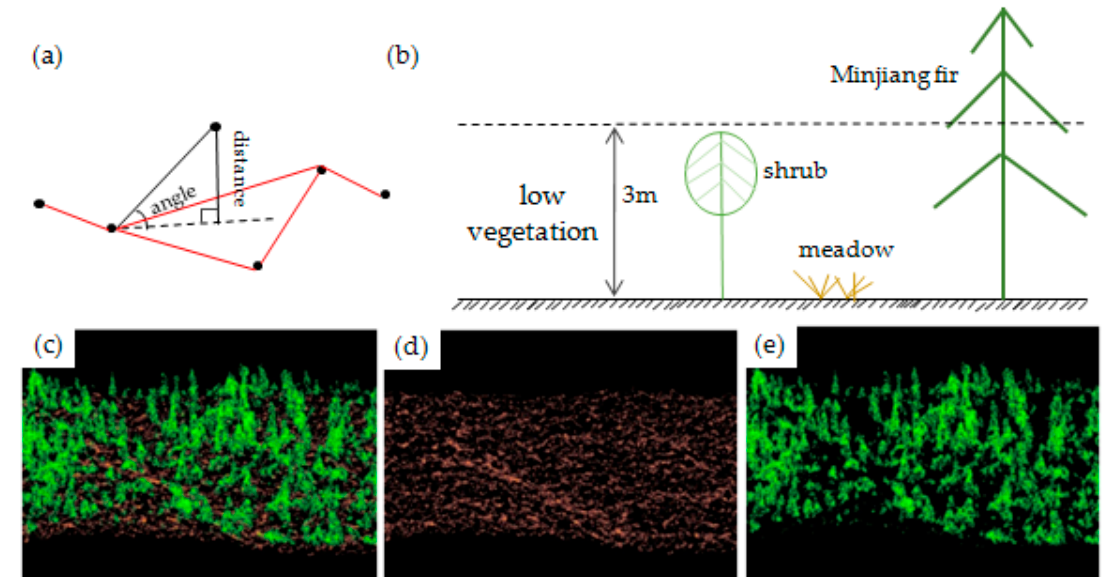
Figure 5. Generation of Digital Terrain Model (DTM), Digital Surface Model (DSM) without low vegetation, and Canopy Height Model (CHM) of the test site: ( a ) gradual densification algorithm for extracting ground points; ( b ) demarcation height for removing low vegetation; ( c ) example DSM removed of low vegetation; ( d ) example DTM; and ( e ) example resulting CHM.